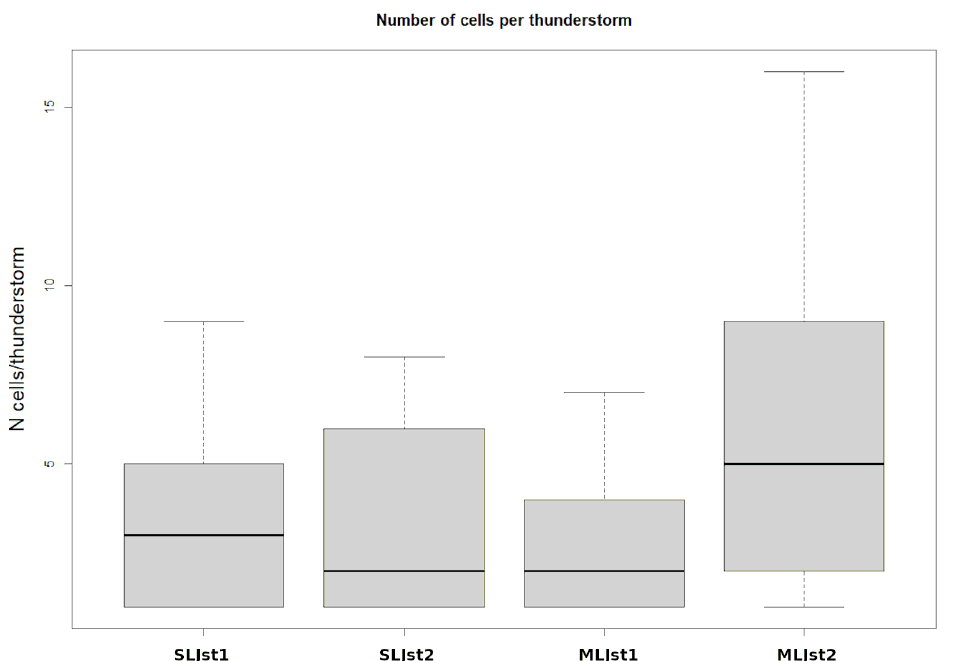
Figure 10. Boxplot of the number of convective cells identified in LJ thunderstorms. From left to right: SLJst1, SLJst2, MLJst1, and MLJst2.